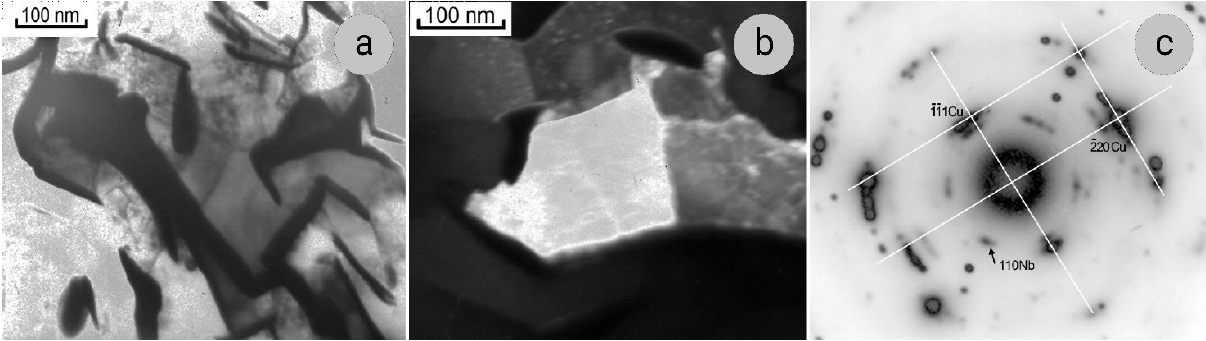
Figure 2. Microstructure of transverse section of Cu – 18Nb composite, Sample 1: ( a ) — bright-field image; ( b ) — dark-field image in (220) Cu reflection; ( с ) — SAED, zone axis [112] Cu.